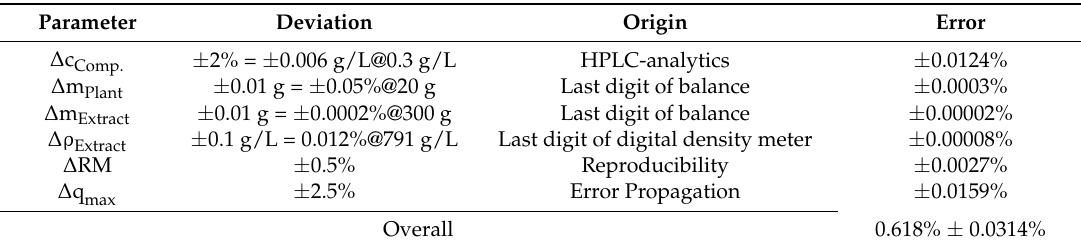
Table 3. Error propagation for the equilibrium measurement.